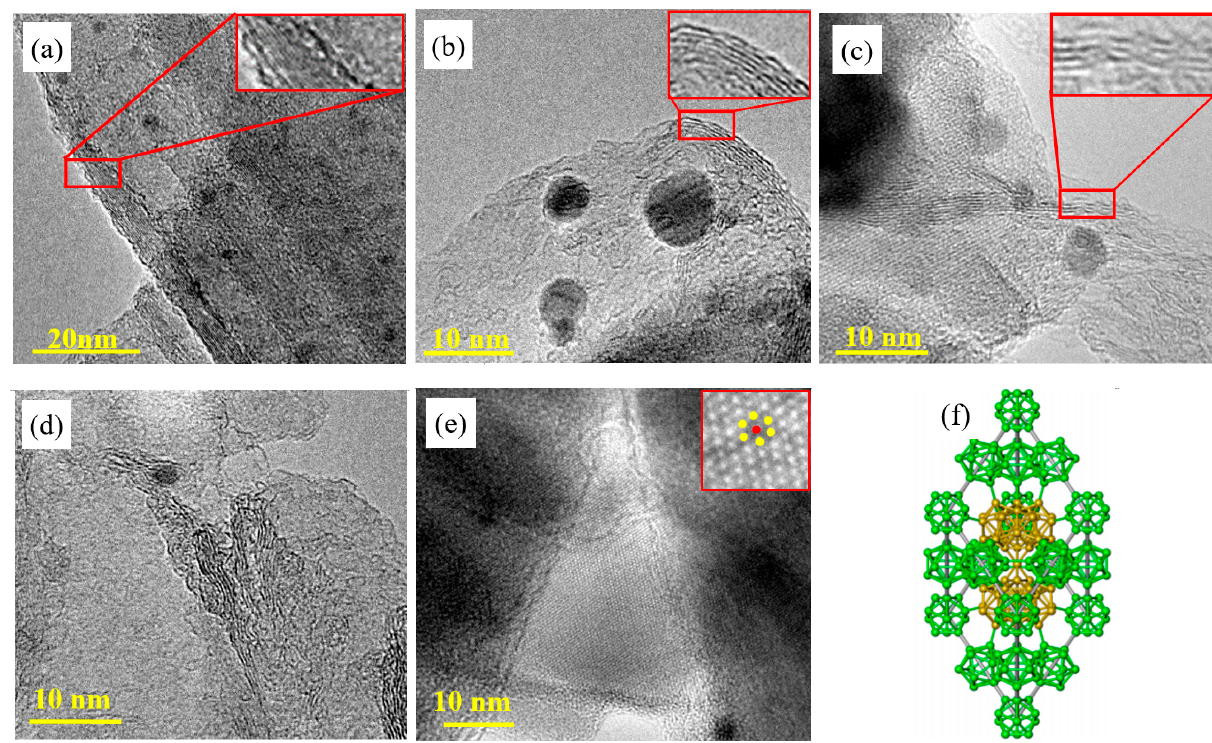
Figure 2. TEM images of boron nanosheets and their peeling processes ( a ) Overlapping boron nanosheets, ( b ) 5-layers boron nanosheets, ( c – e ) 2–3 layers of boron nanosheets, and their enlarged peeling processes, ( f ) Structure model of β -B.